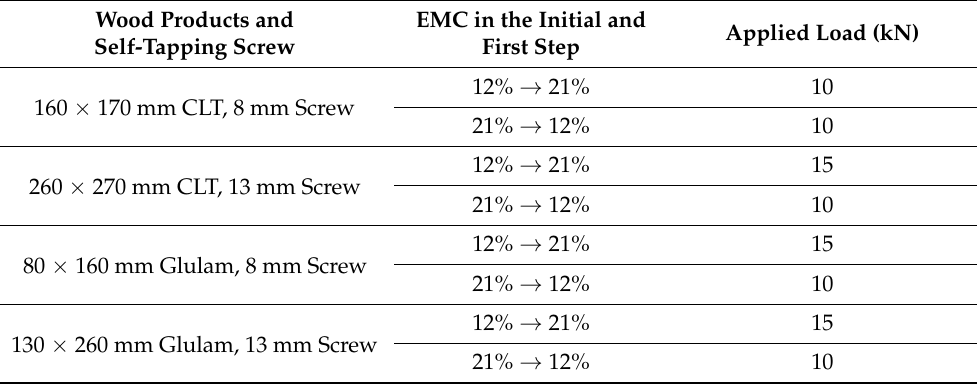
Table 24. Axial load applied to the finite element model for analytical model verification.